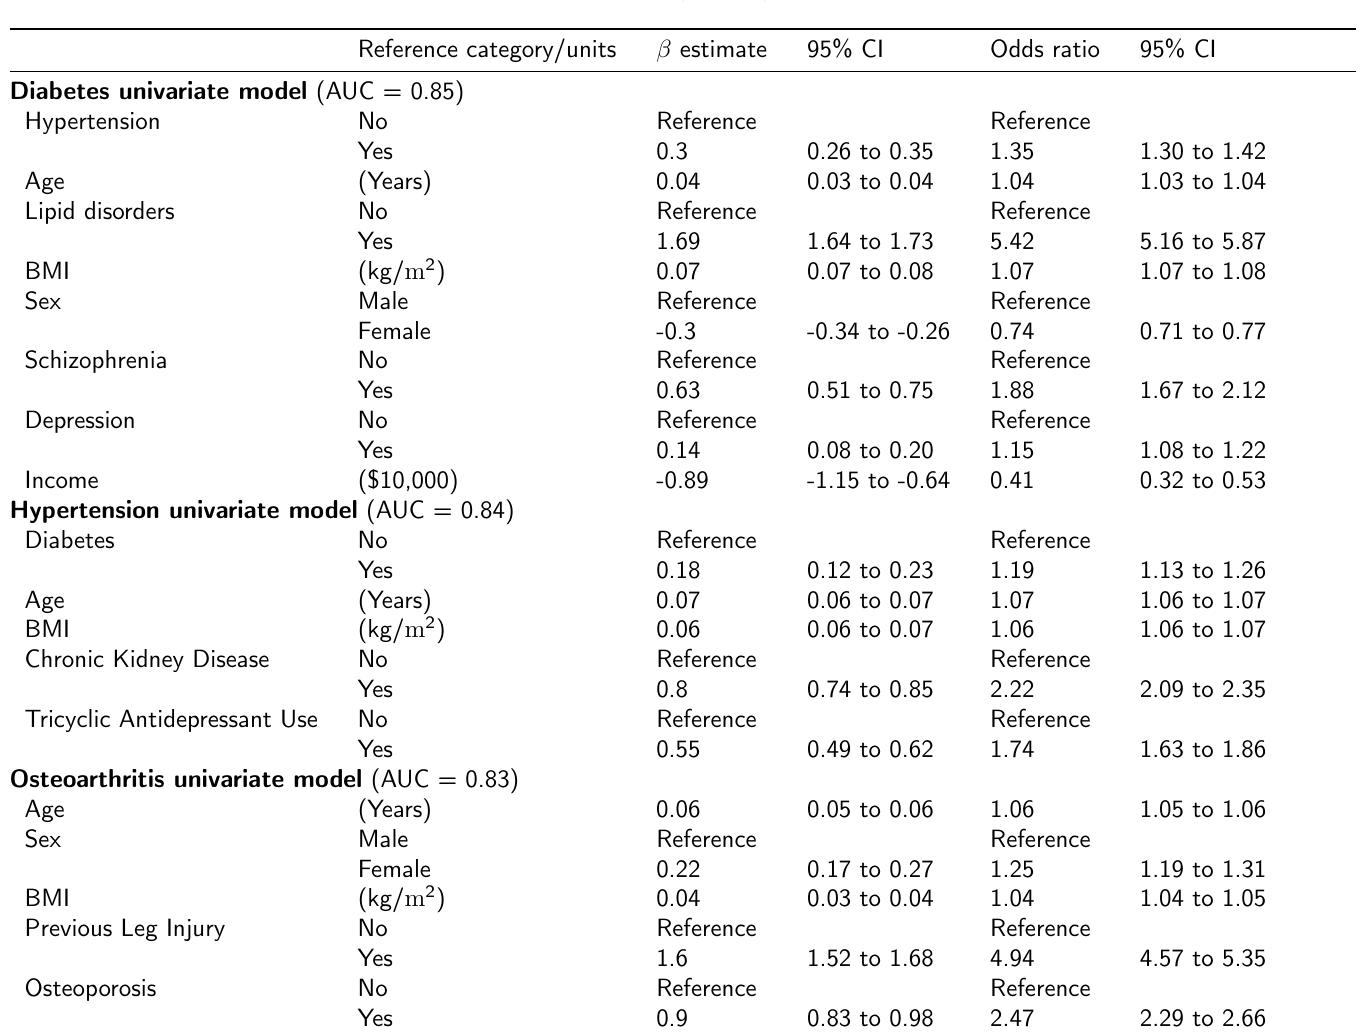
Table 3: Univariate logistic regression